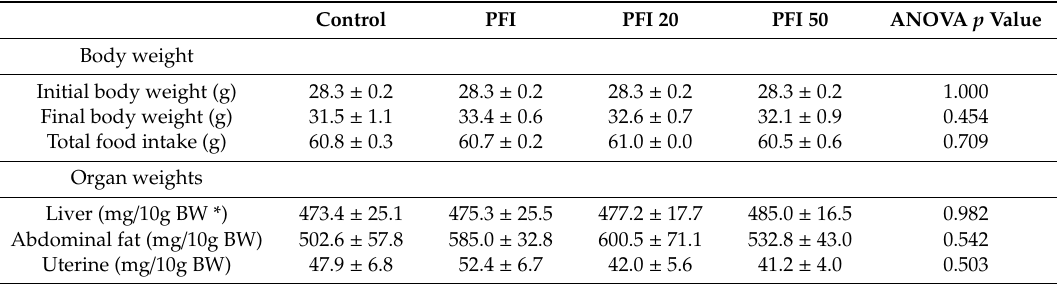
Table 1. Body weight, food intake, and wet weight of liver, abdominal fat, and uterine in mice in Experiment